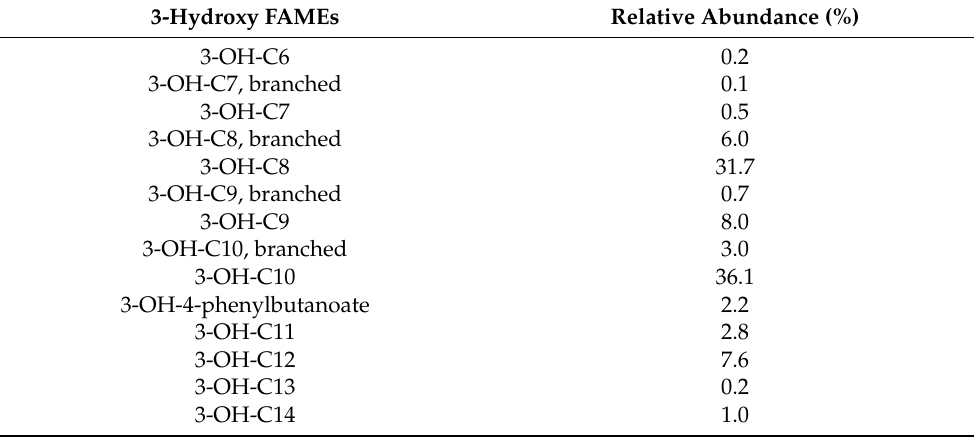
Figure 10. Proposed ESI-fragmentation pathways of succinic saccharide esters discussed in this study. Table 4. 3-hydroxy fatty acyl composition of the 90% MeOH fraction from crude extract I2R SV2 SW.